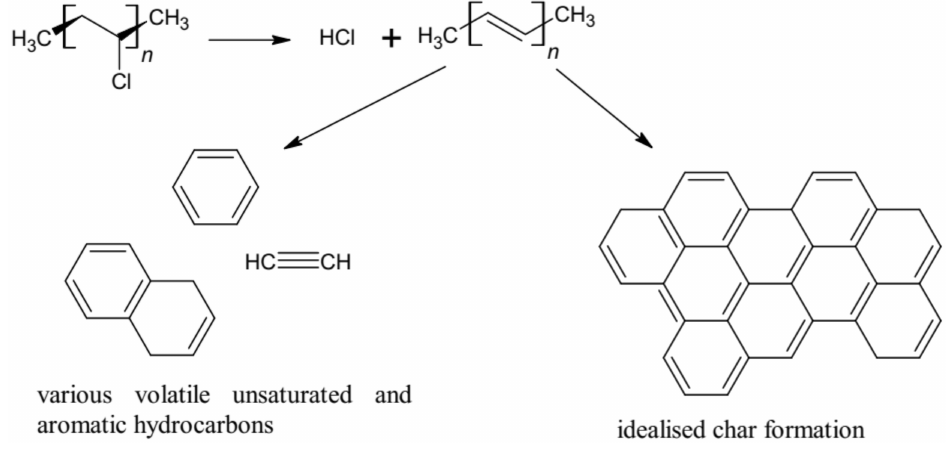
Figure 8. PVC decomposition process.